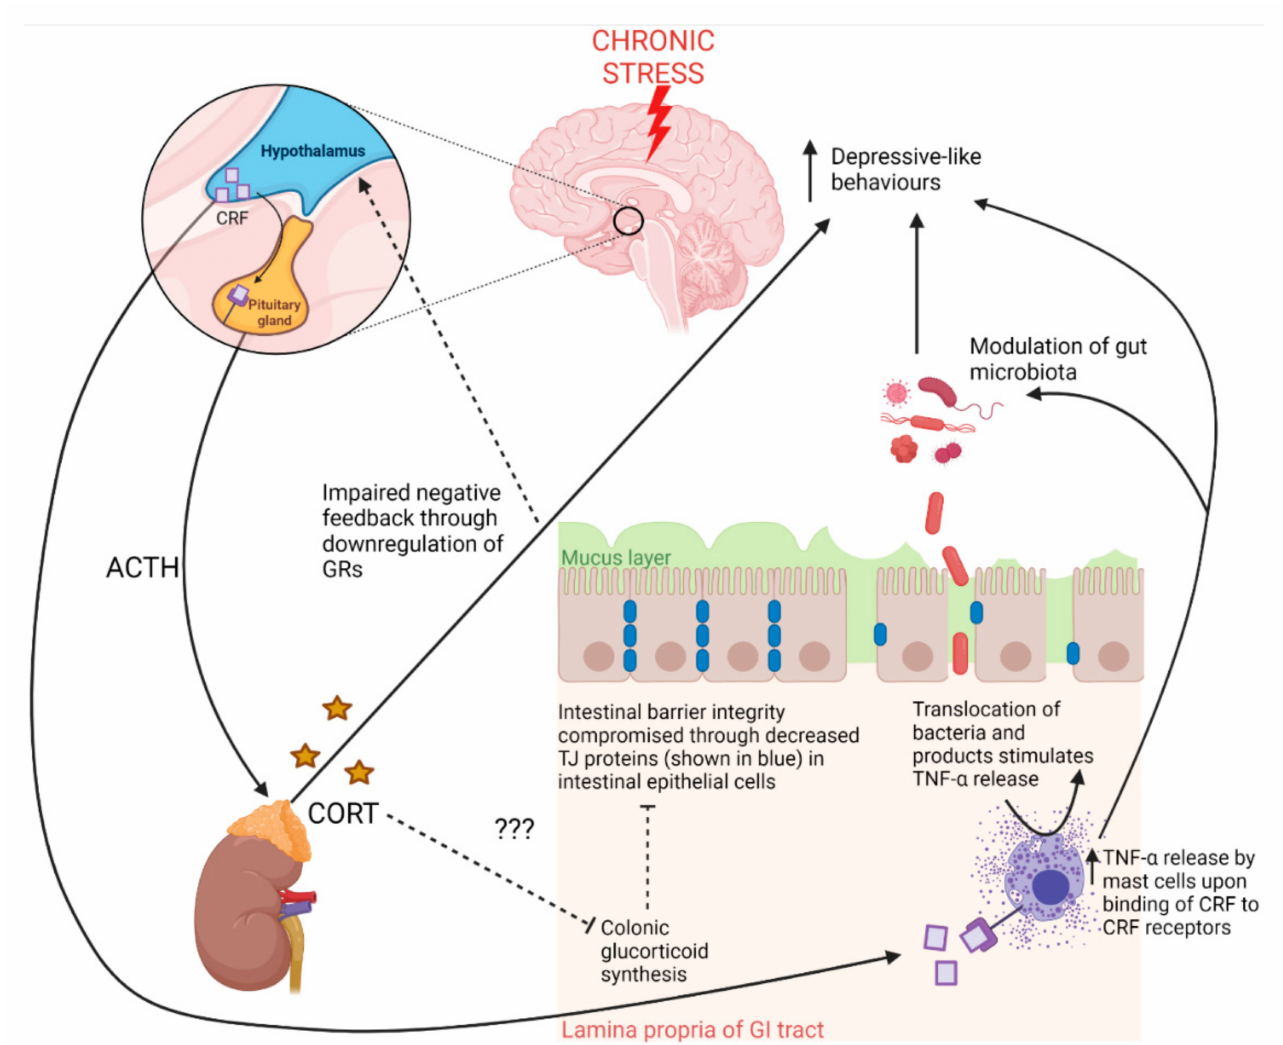
Figure 2. The contributions of the hypothalamic–pituitary–adrenal (HPA) axis to gut pathology and behaviour in response to chronic stress. Exposure to stress stimulates corticotropin releasing factor (CRF) release from the hypothalamus, which induces pituitary release of adrenocorticotropic hormone (ACTH) [2]. ACTH stimulates the release of corticosterone (CORT) from the adrenal cor- tex [2]. Chronic stress downregulates hippocampal glucocorticoid receptors (GRs), which bind CORT regulating negative feedback of the HPA axis under normal conditions [6]. Chronic stress thus leads to chronically elevated CORT levels, which are known to lead to depressive-like behaviours. Under chronic stress, CRF production by the hypothalamus may also reach the circulation where CRF may travel to the gut and bind CRF receptors on mast cells, inducing intestinal inflammation and compro- mising intestinal barrier integrity [32,34]. Some evidence indicates that colonic glucocorticoids may contribute to the maintenance of intestinal barrier integrity and that colonic glucocorticoid synthesis occurs through separate mechanisms to adrenal-derived glucocorticoids [34]. Adrenal-derived gluco- corticoids may also inhibit colonic glucocorticoid synthesis, thus corroborating findings of impaired intestinal barrier integrity existing with a dysregulated HPA axis [34]. GI tract—gastrointestinal tract; TJ—tight junction